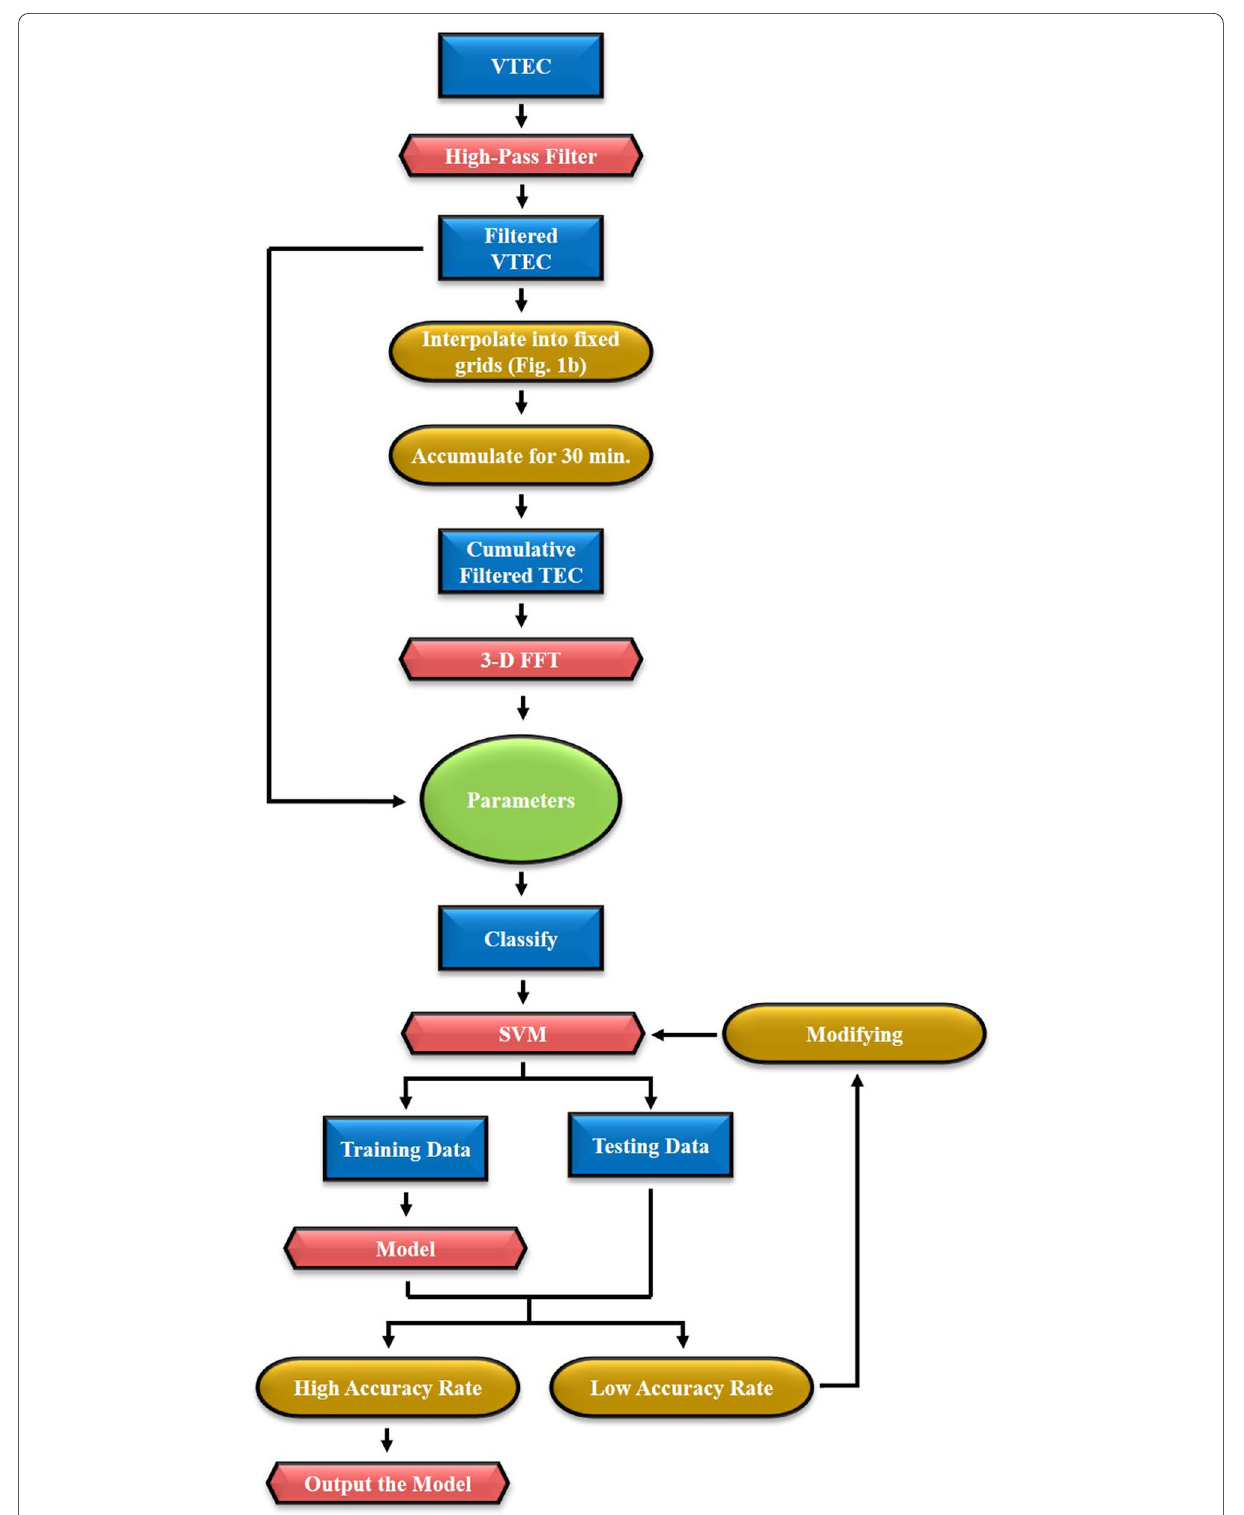
Fig. 2 Flowchart of the procedure of creating an SVM model for classifying different ionospheric